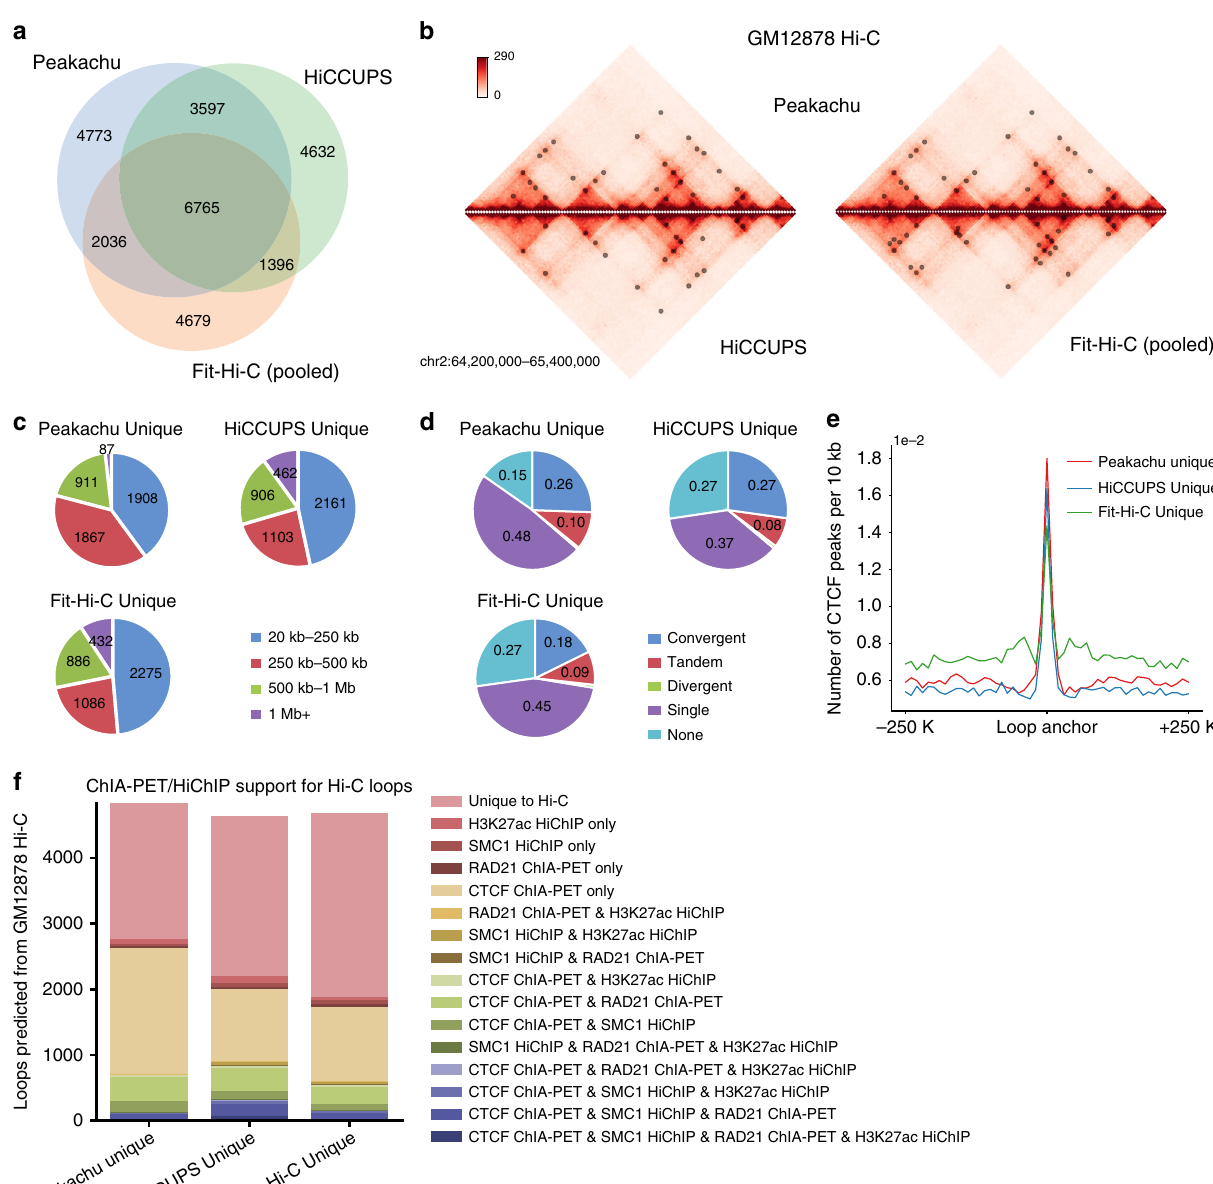
Fig. 3 Comparison of Peakachu, HiCCUPS, and Fit-Hi-C in GM12878 Hi-C. a Venn diagram of loops predicted by different methods. The original signi fi cant interactions from Fit-Hi-C were pooled by the same algorithm used in Peakachu. Parameters of HiCCUPS and Fit-Hi-C were tuned to make the number of loops uniquely predicted by each method similar. b Visualization of loops. c Distance distribution of loops uniquely detected by each method. d CTCF motif patterns of uniquely detected loops by each method. e CTCF binding pro fi le surrounding loop anchors. f Overlap loops uniquely detected by each method with ChIA-PET/HiChIP interactions. Source data are available in the Source Data fi